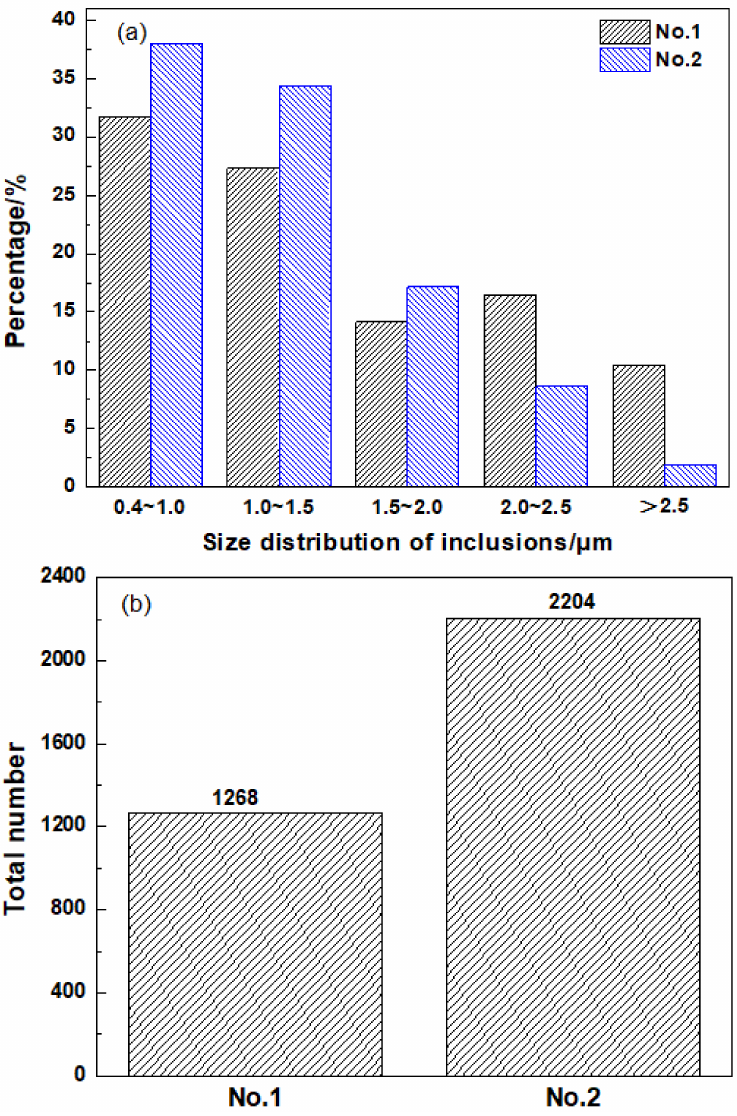
Figure 6. Size and number of inclusions in HAZ. ( a ) Non-metallic inclusion particle size distribution and ( b ) total number of nonmetallic